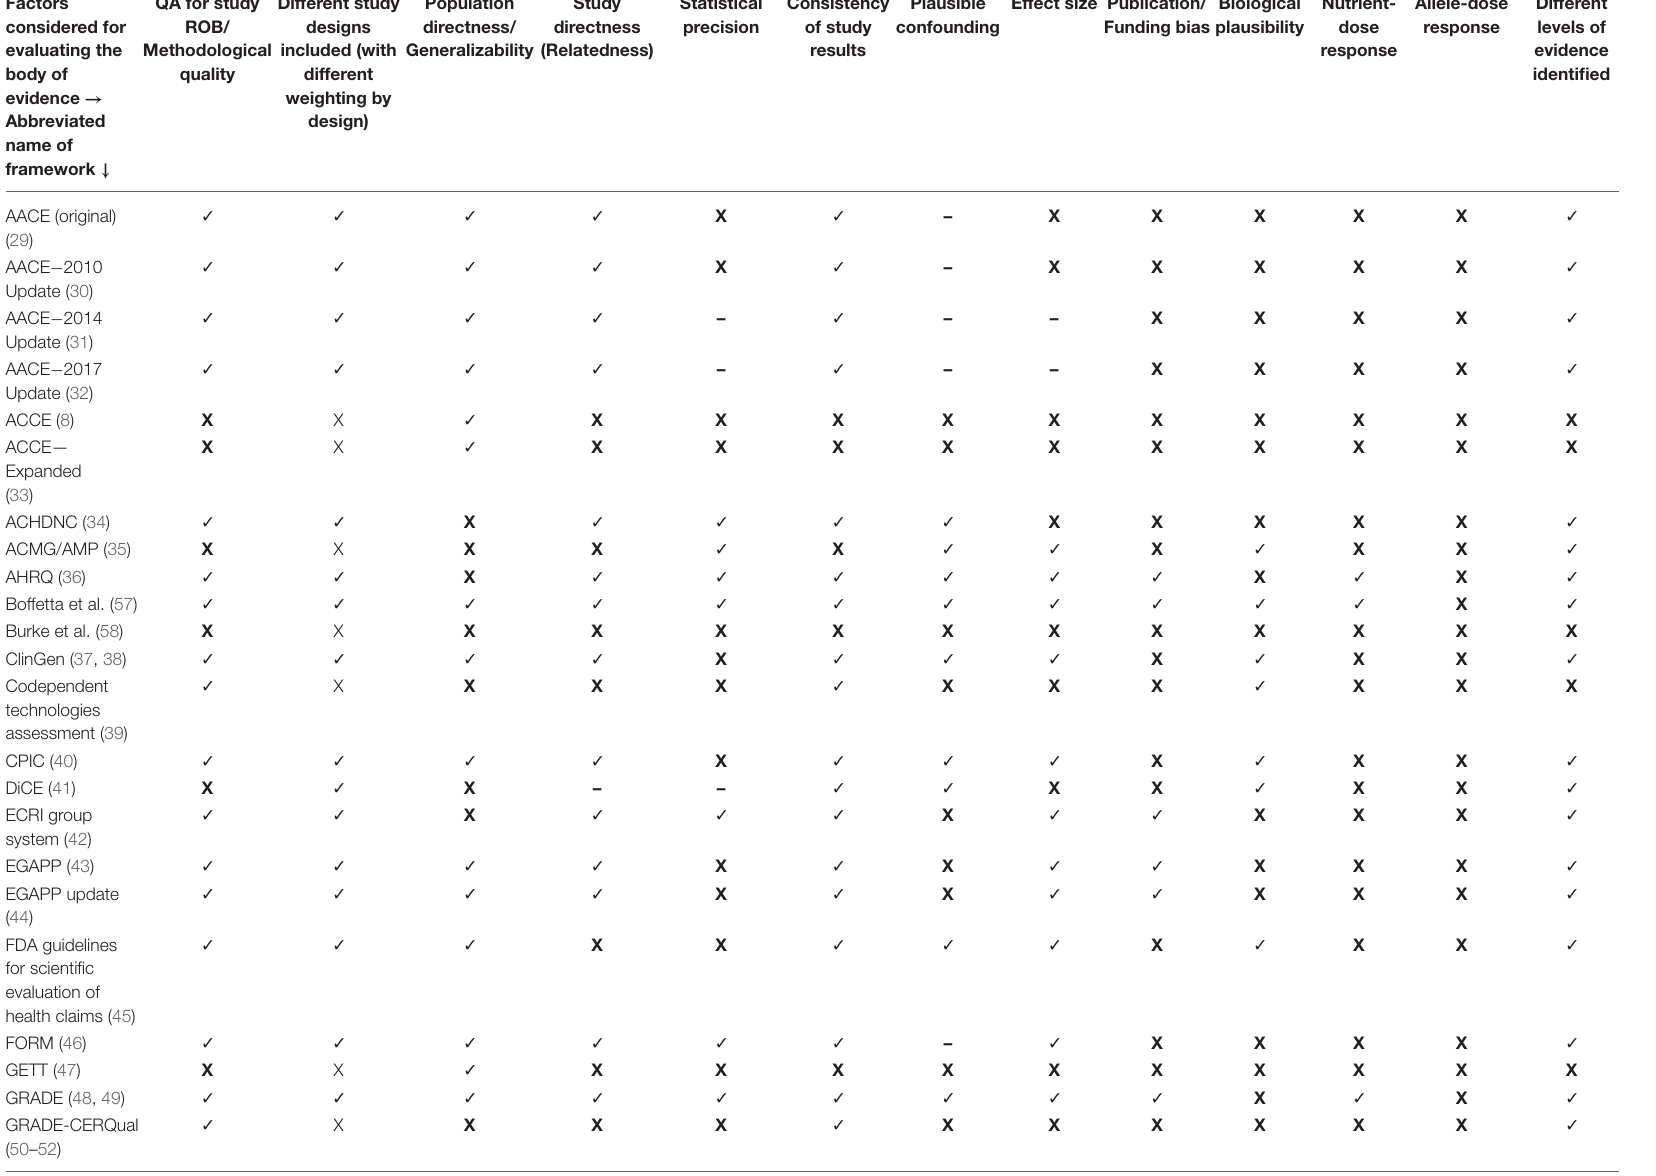
TABLE 3 | Categorization matrix to determine the appropriateness of existing tools for evaluating the scientific validity of nutrigenetic interactions. Factors considered for evaluating the body